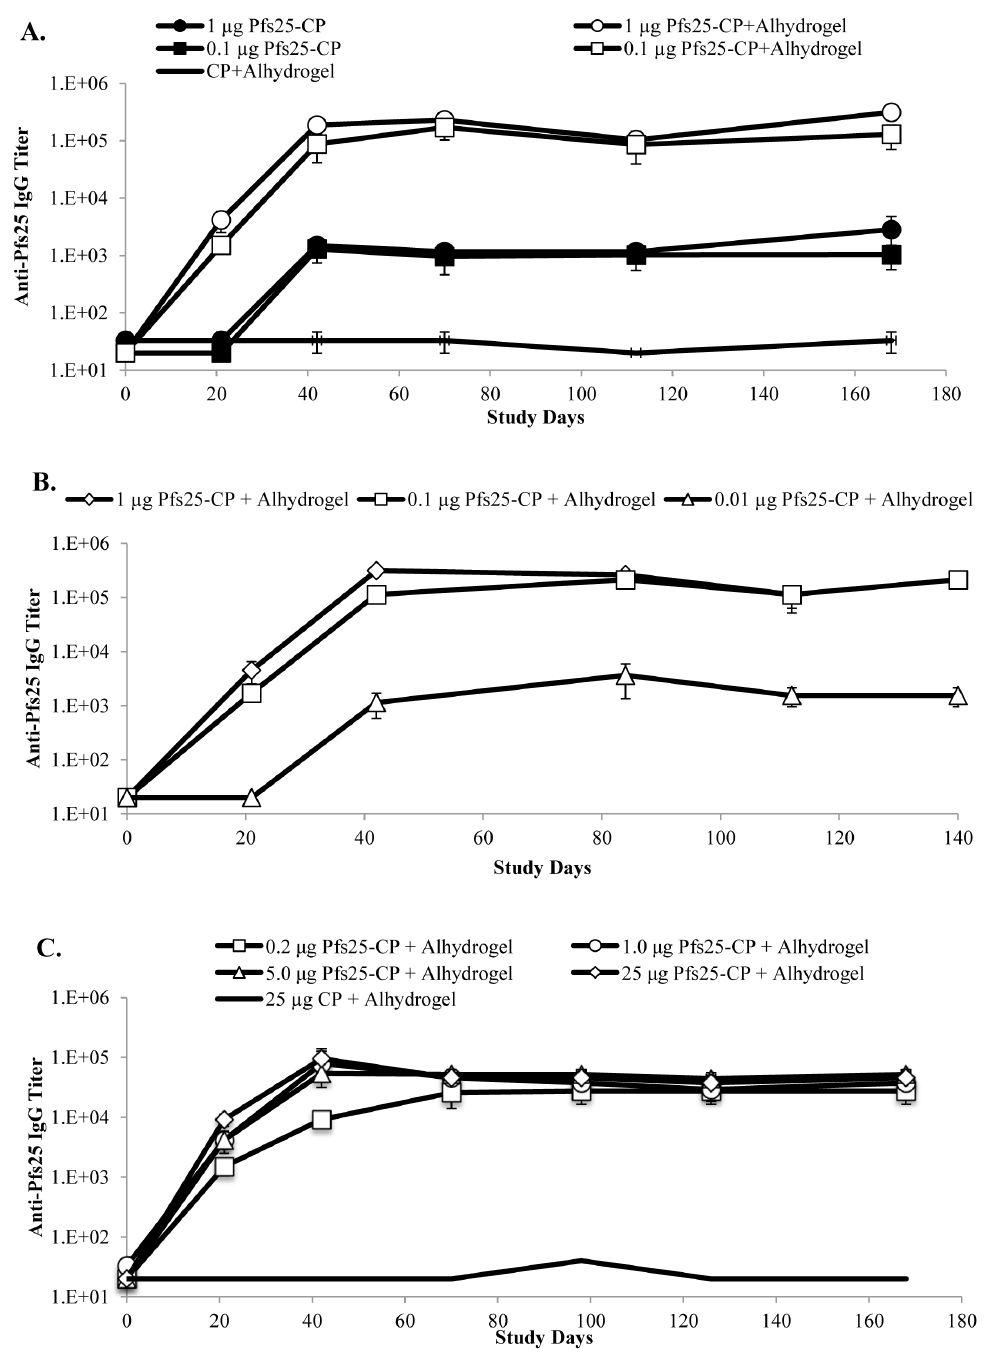
Figure 4. Anti-Pfs25 IgG responses in mice determined by ELISA. (A) Average anti-Pfs25 IgG titers from mice immunized with two doses of either 1.0 m g (circles) or 0.1 m g (squares) of Pfs25-CP VLPs, each with (open symbols) or without (filled symbols) Alhydrogel H , or 5.0 m g of CP only (black line). (B) Average anti-Pfs25 IgG titers from mice immunized with two doses of either 1.0 m g (circles), 0.1 m g (squares) or 0.01 m g (diamonds) of Pfs25-CP VLPs with Alhydrogel H . (C) Average anti-Pfs25 IgG titers elicited by a single administration of Pfs25-CP VLPs with Alhydrogel H at antigen doses ranging from 0.2–25 m g. Data are represented as average values per group of mice 6 standard error of the mean. doi:10.1371/journal.pone.0079538.g004 with the general observation that particle-like structures have also adjuvanted with Alhydrogel H began in the latter part of 2011 (http://www.clinicaltrials.gov/ct2/show/NCT01434381). been shown to improve the immunogenicity of recombinant subunit immunogens [49], including malaria antigens [50]. A Plants represent an alternative system for expression of complex Phase 1 clinical trial of the Pfs25-EPA vaccine candidate eukaryotic proteins, including Pfs25. We have previously reported on the production of soluble, full-length (lacking the glycosylpho-